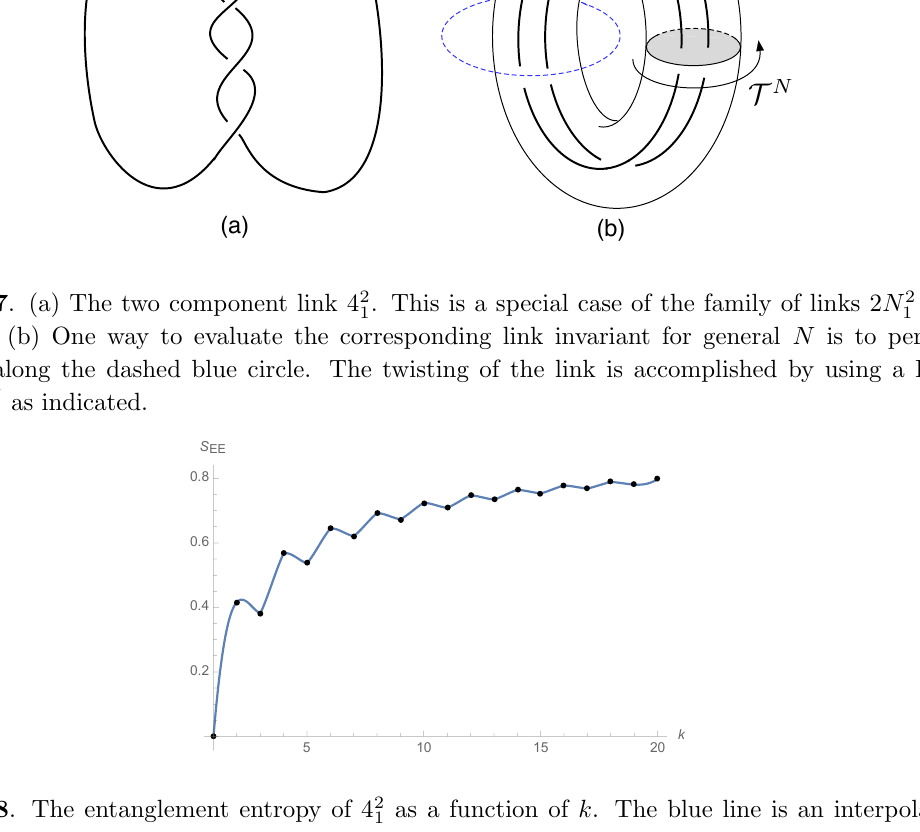
Figure 8 . The entanglement entropy of 4 2